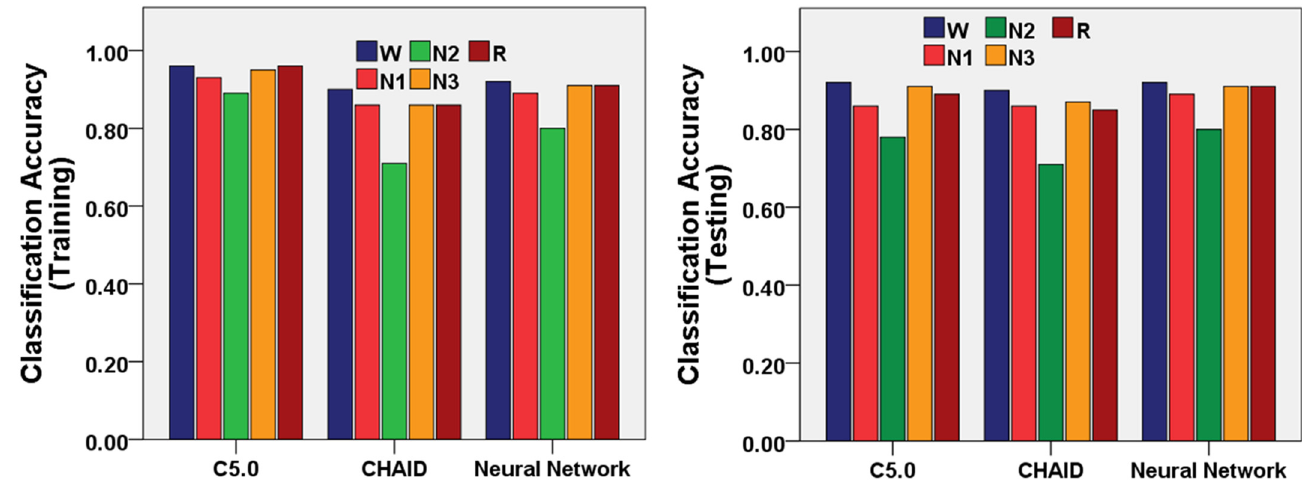
Figure 4. Performance of the three machine-learning models (C5.0, Neural Network, and CHAID